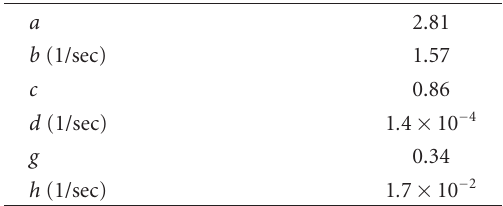
Table 1: QLV relaxation model